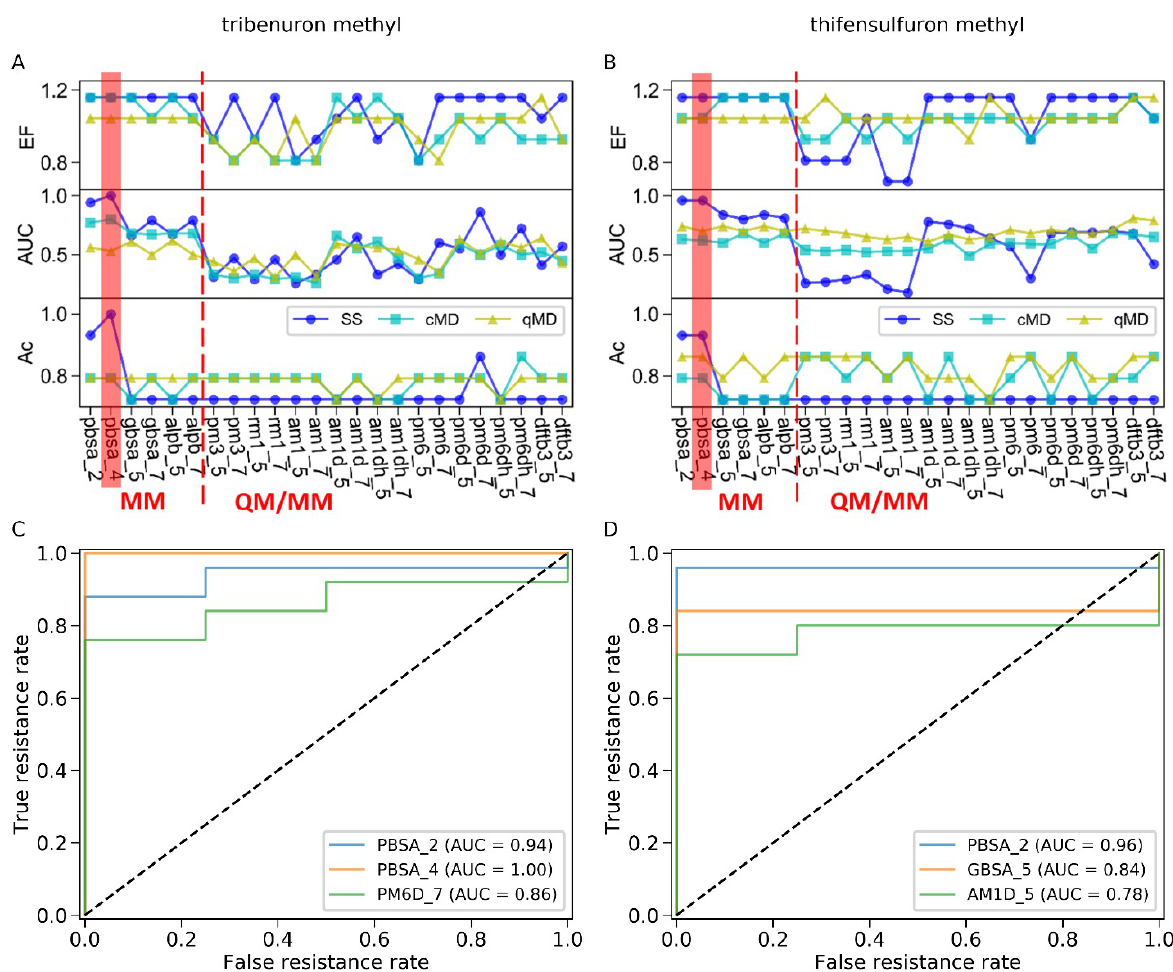
Fig 4. Prediction performance of 24 binding affinity estimation methods in combination with three conformational sampling strategies evaluated by EF, AUC, and accuracy (Ac). (A) Performance metrics for prediction on resistance to tribenuron methyl. (B) Performance metrics for prediction of resistance to thifensulfuron methyl. (C) The top three ROCs for tribenuron methyl. (D) The top three ROCs for thifensulfuron methyl. PBSA_2/4 is the MM-PBSA with ε of 2 or 4. The GB OBC and GBn models are represented by 5 and 7, respectively. Binding affinity was computed on the basis of single structure minimized (SS), structures sampled from classical MD simulations (cMD), or structures extracted from QM/MM MD simulations (qMD).